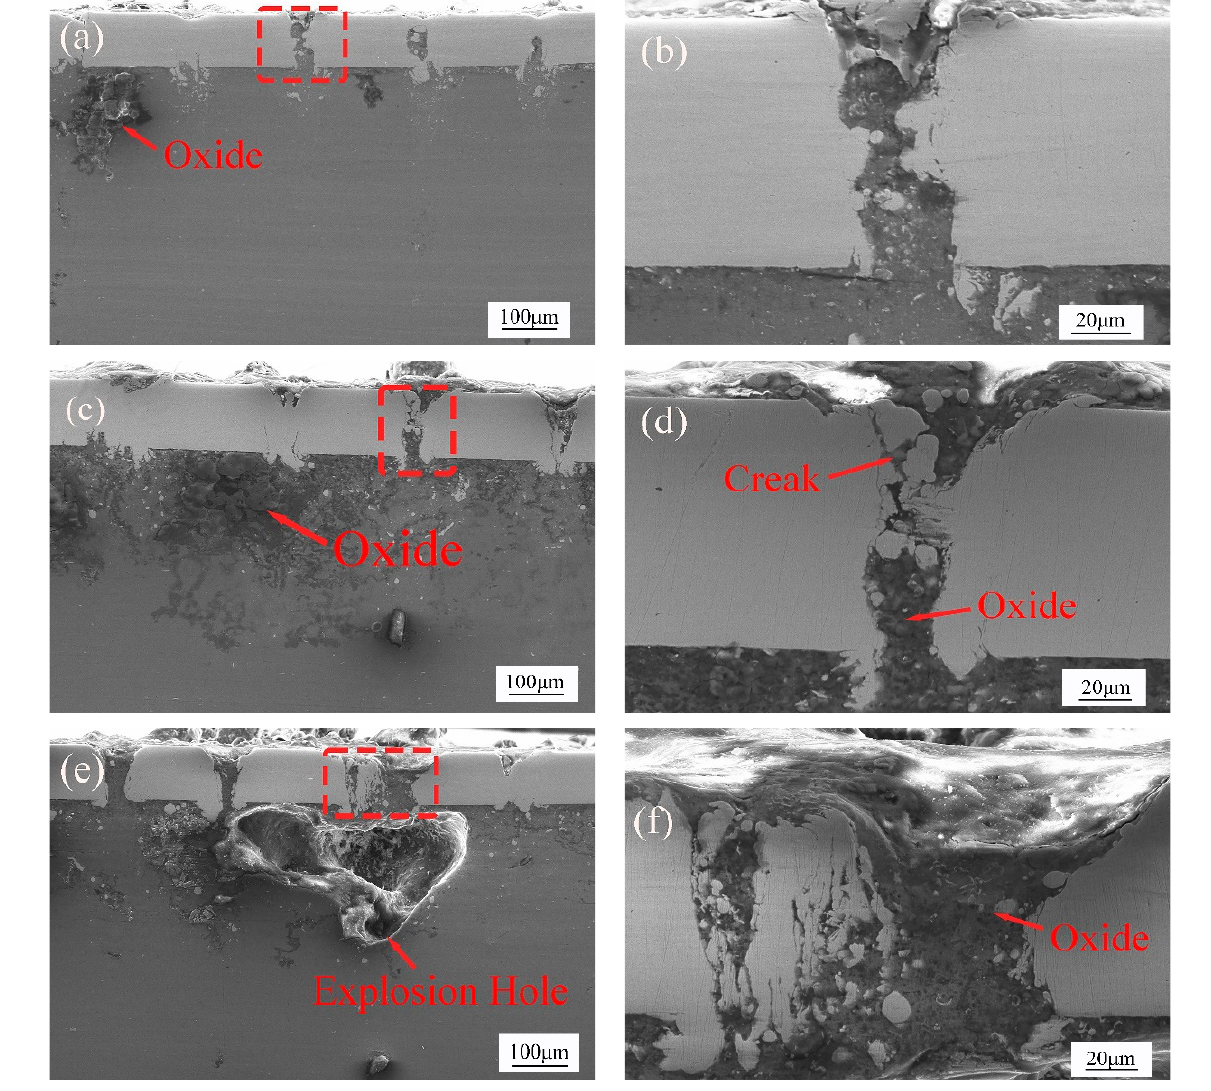
Figure 8. Cross section of weld ( a , b ) laser power 40 W, ( c , d ) laser power 45 W, ( e , f ) laser power 50